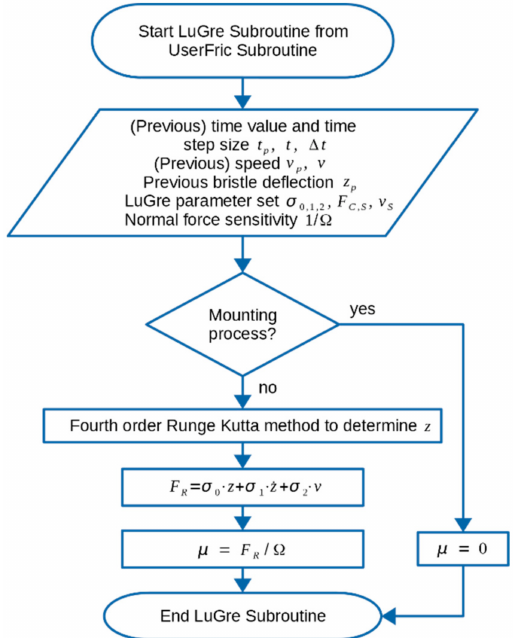
Figure 7. Program flow chart of the LuGre